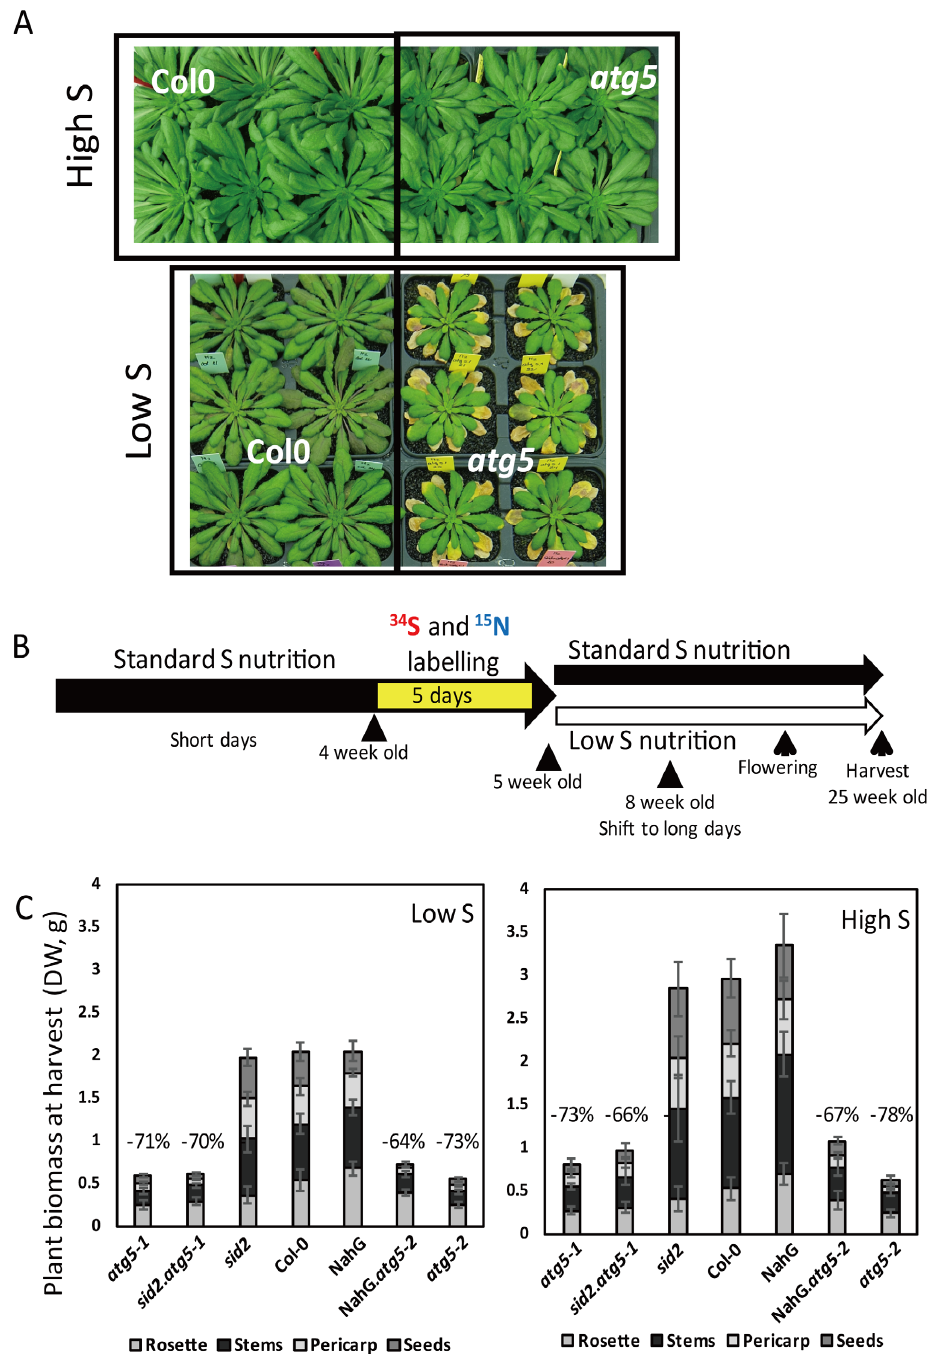
Figure 1. The biomass of atg5 autophagy mutants is affected under both low sulphur (Low S) and high sulphur (High S) conditions. ( A ) Phenotype of atg5 mutants under high S and low S conditions 60 days after sowing. ( B ) Schematic representation of the labelling experiments performed on atg5 mutants ( atg5-1 , atg5-2 , atg5-1.sid2 , atg5-2. NahG) and control lines (Col-0, sid2 and NahG). The plants were sown on sand and cultivated under high S conditions for four weeks in short days (8 h light–16 h dark, 150 µmoL/m 2 /s 1 ). Then, the plants were labelled for five days using a high S nutrient solution containing 15 N and 34 S isotopes. After 5 d labelling, half of the plants were transferred to unlabelled